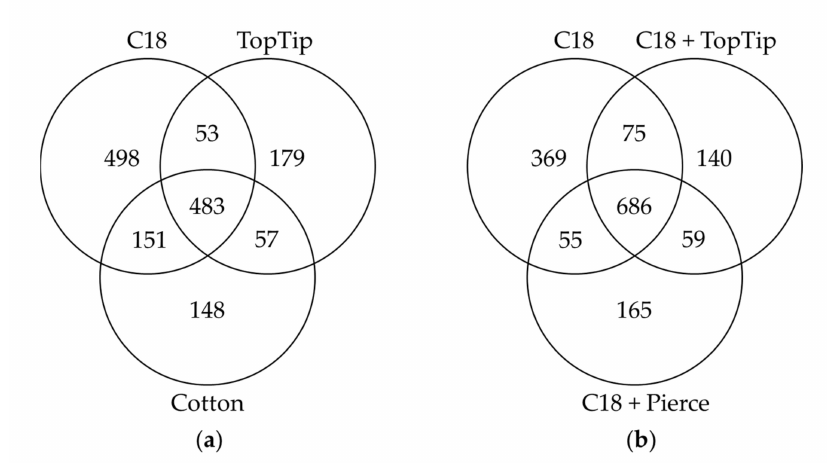
Figure A2. ( a ) Peptide detection overlap for the C18, TopTip, and Cotton methods. ( b ) Peptide detection overlap for the C18 and the two combined methods. Table A1. The different glycans detected (attached to the glycopeptide backbone) with each